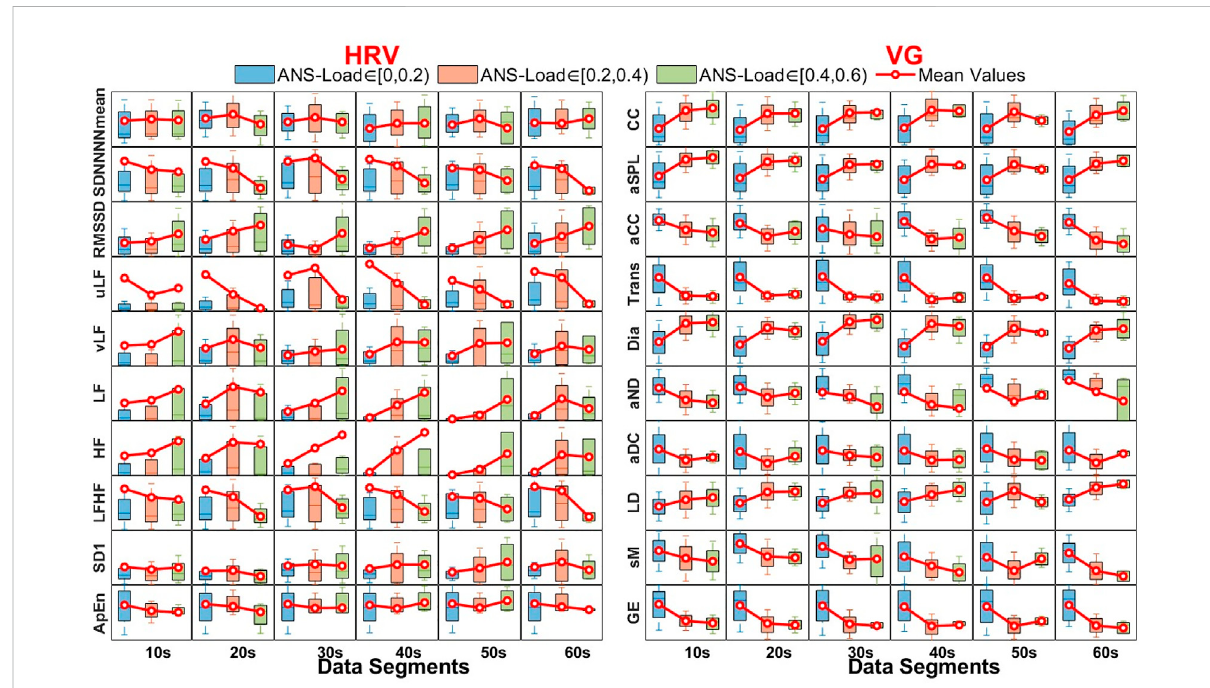
FIGURE 6 The distributions between each HRV and VG features and data lengths under different ANS-Load and their corresponding mean